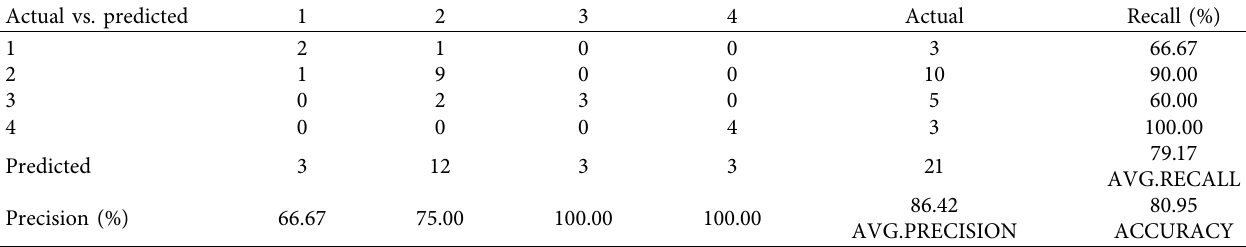
Table 6: Confusion matrix of decision tree model test results and model evaluation related indicators. Actual vs. predicted